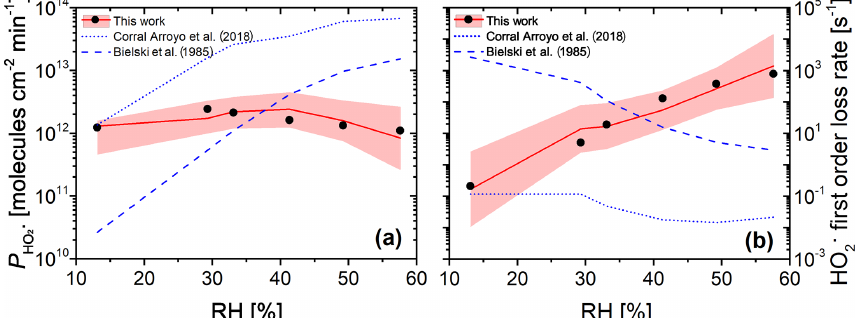
Figure 12. (a) Measured (black dots, experimental uncertainty of 3% smaller than symbol size) and modeled (red line and shaded area) HO . production from continued photochemistry of Fe III ( Cit )/ CA (molar ratio of 0.07) films as a function of RH in CWFT experiments. 2 Dotted and dashed blue lines were determined from parameterization of k 5 as a function of RH (Corral Arroyo et al., 2018) and k 5 = 8 . 3 × 10 5 M − 1 s − 1 in dilute aqueous solution (Bielski et al., 1985), respectively. (b) The maximum HO . first-order loss rate determined 2 from the result of the maximum HO . concentration times HO . self-reaction rate, k 5 , which was adjusted to match observations in panel (a ) 2 2 (black dots), or times k 5 parameterized as a function of RH for our PRAD model (Eq. A11) with confidence interval of 95% (red line and shading), or times k 5 from Corral Arroyo et al. (2018) (dotted blue line), or k 5 = 8 . 3 × 10 5 M − 1 s − 1 (Bielski et al., 1985) (dashed blue line).